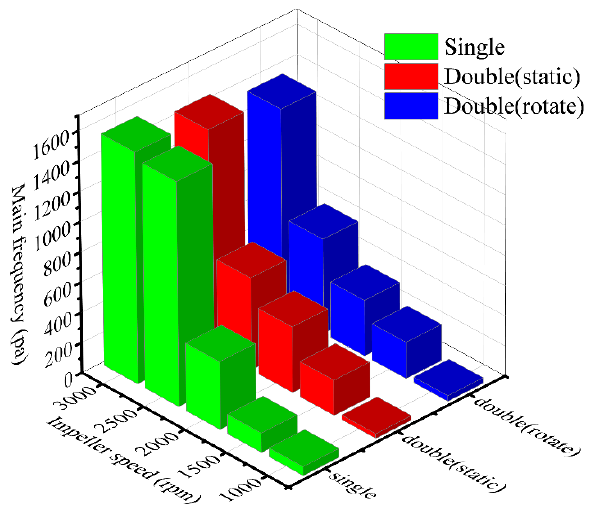
Figure 12. Dominant frequency amplitudes of pressure pulsation for three volutes at different impeller speeds.